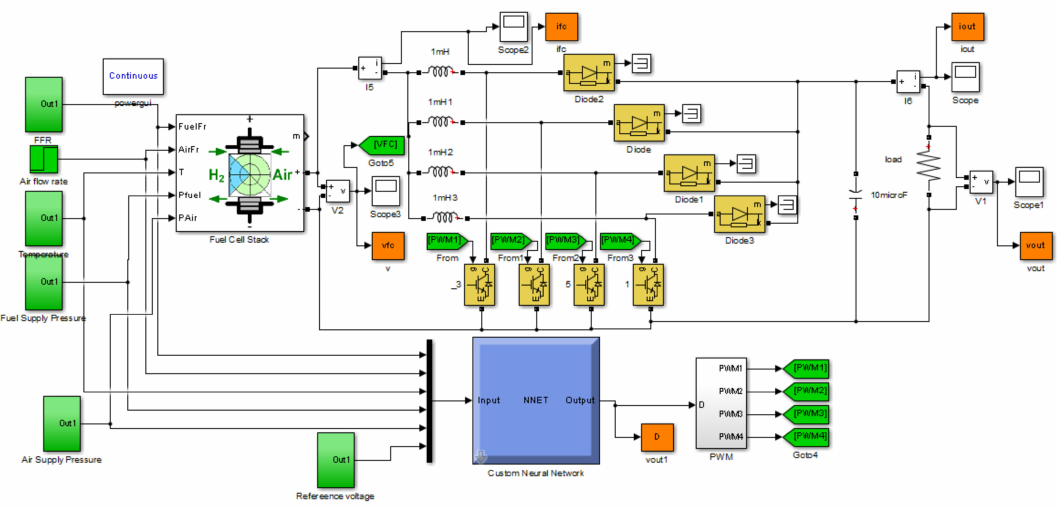
Figure 10. Fuel Cell- Boost Converter System and Neural Network Controller.